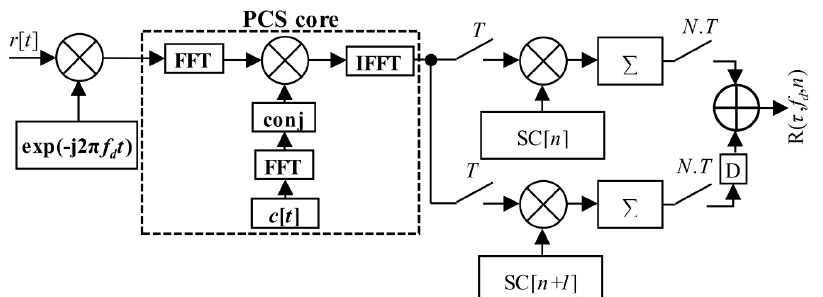
Figure 18. Proposed mSBZP schema for SC acquisition in post-correlation processing .